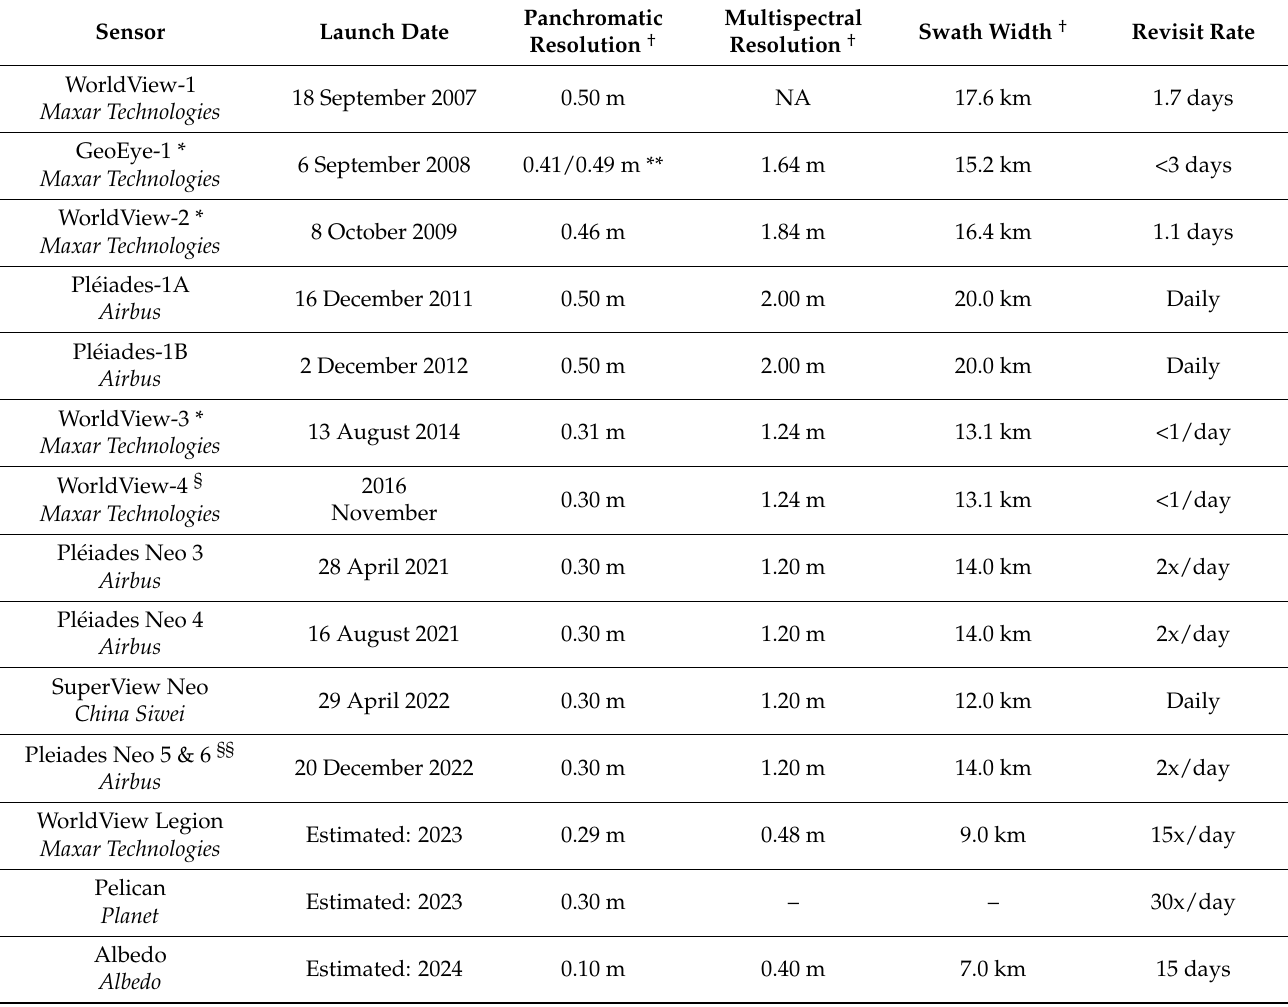
Table 2. Sensors collecting ≤ 0.50 m resolution very high-resolution satellite imagery